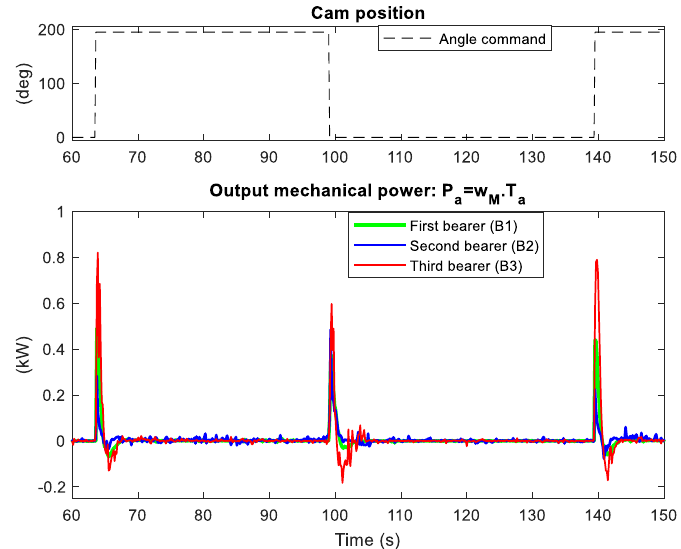
Figure 14. Mechanical power of the three bearers when the system operating with all three bearers; B1, B2 and B3.